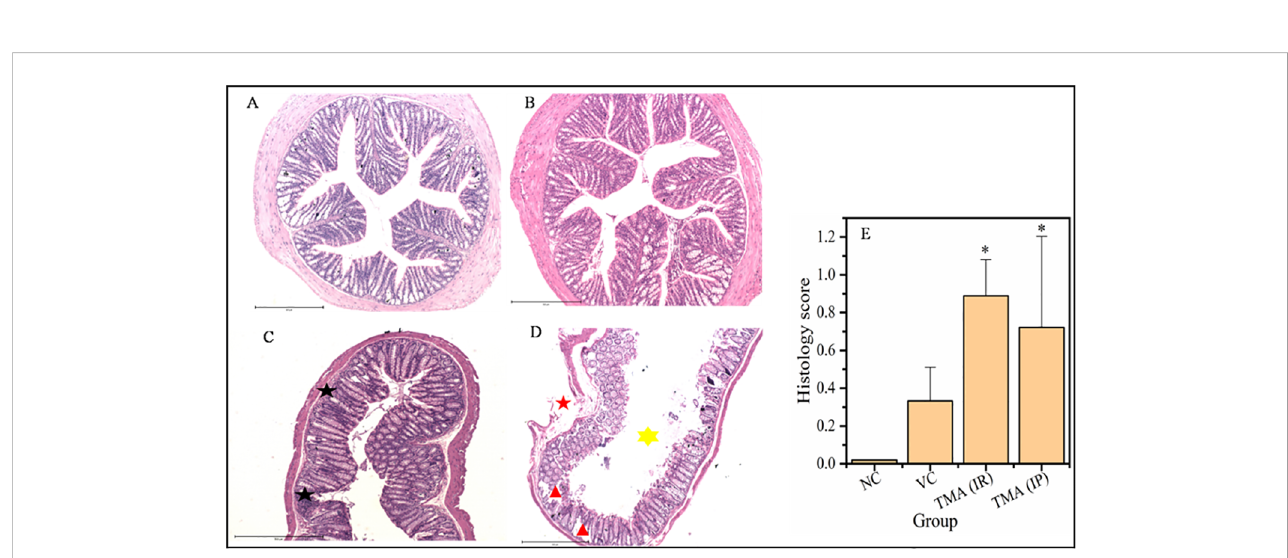
FIGURE 8 Micrographs of the colon (A-D) and histological score of all groups (E) . H & E sections of colon from mice exposed to TMA intraperitoneally (C) and intrarectally (D) or negative control (A) or vehicle control (B) are shown. Severe in fl ammation characterized by severe cellular in fi ltration persisted in the colon of mice exposed to TMA intrarectally (D) compared to negative and vehicle control. Black star point to cellular in fi ltration, red star points to damaged muscularis, yellow star points to increased lumen and red triangle points to distorted crypts. The histology scores for the in fl ammation of these groups are summarized in (E) . The histological score showed a signi fi cant increase in in fl ammation after TMA exposure. * p